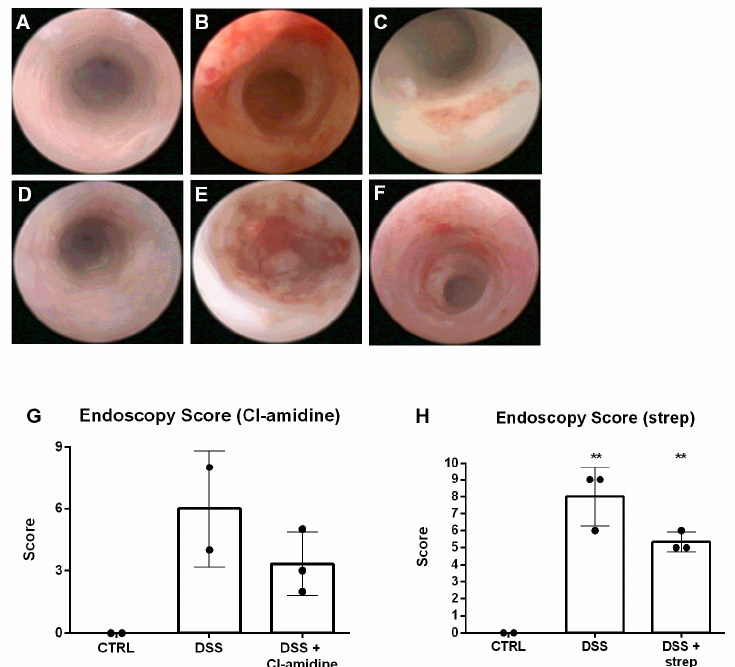
Figure 8. Representative images of endoscopic visualization of the colonic mucosa. When compared to negative ( A ) and positive control ( B ), administration of Cl-amidine visibly alleviated intestinal inflammation ( C ). Application of strep ( F ) managed to partially suppress the inflammation as well compared to negative ( D ) and positive control ( E ). Endoscopy score confirmed the partial amelioration of both Cl-amidine ( G ) and strep ( H ) treatment. ** = 0.05 > p > 0.01.